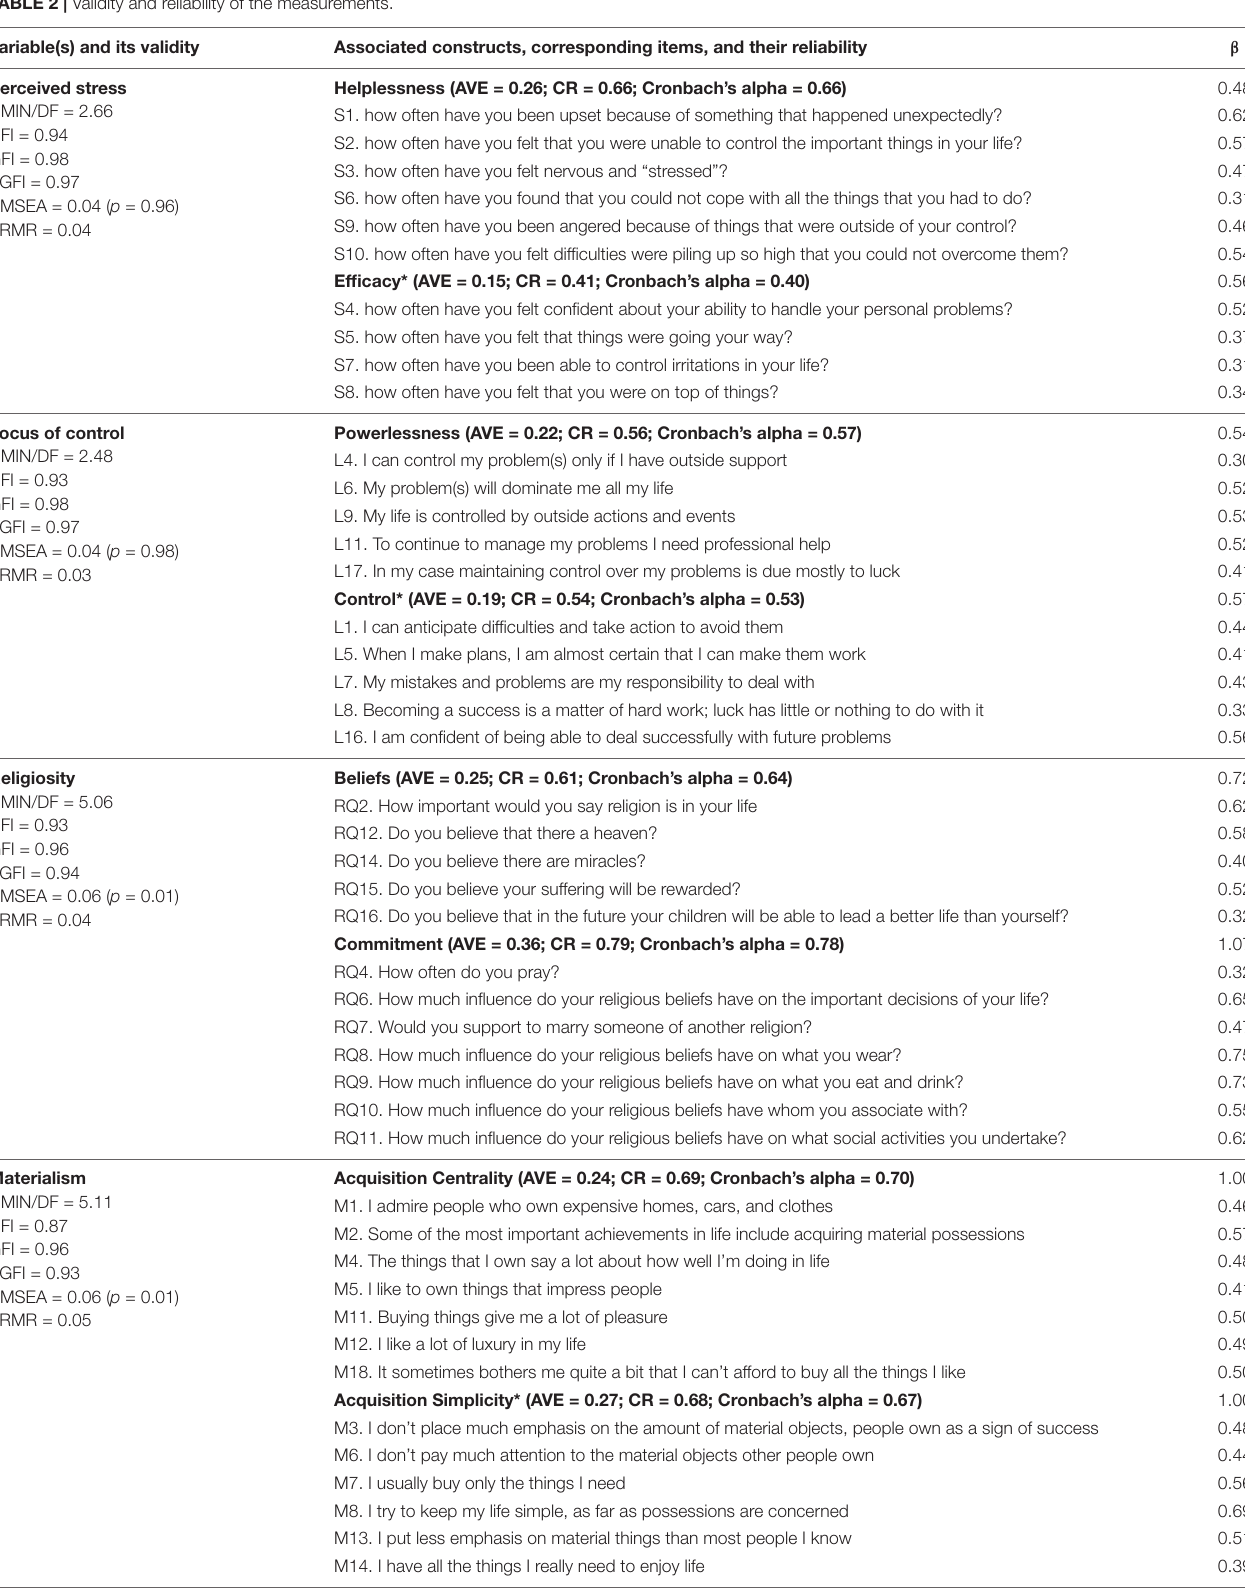
TABLE 2 | Validity and reliability of the measurements. Variable(s) and its validity Associated constructs, corresponding items, and their reliability β Perceived stress CMIN/DF = 2.66 CFI = 0.94 GFI =